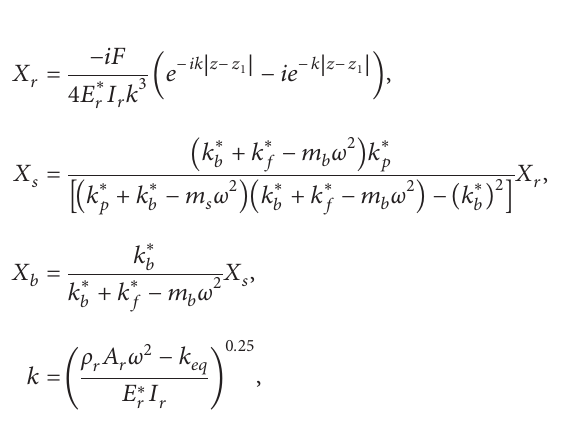
Figure 7: Vibration spectra for points (a) V 1 and (b) V 3 on the steel